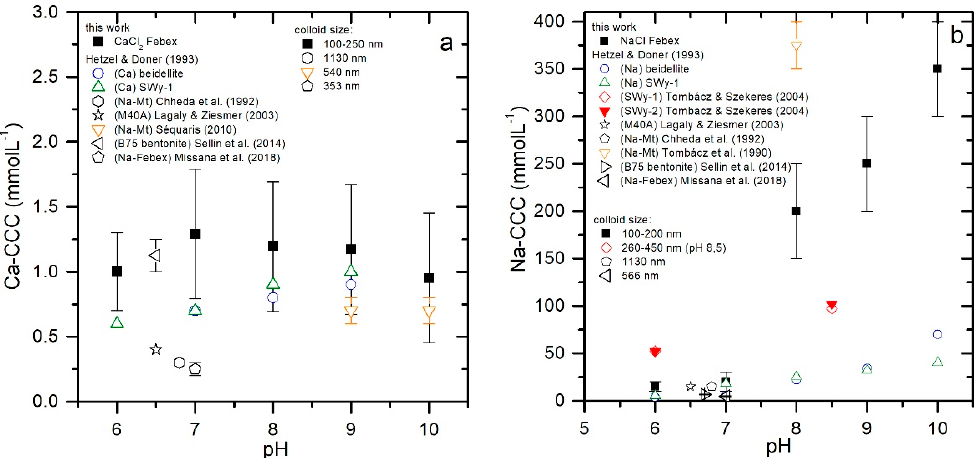
Figure 3. Critical coagulation concentration (CCC) plotted against pH for CaCl 2 ( a ) and NaCl ( b ). The Ca-CCC does not change within the analytical uncertainty for the investigated pH range. For comparison, the CCC data and colloid sizes from Hetzel and Doner [52] for montmorillonite (Swy-1) and beidellite; Na-montmorillonite from Séquaris [53]; Na-montmorillonite (Wyoming, M40A) from Lagaly and Ziesmer [55]; Na-montmorillonite (Fischer) from Chheda et al. [56]; Wyoming montmorillonite Swy- 1 and Swy-2 from Tombácz and Szekeres [59]; Na-montmorillonite from Tombácz et al. [60]; B75 bentonite from Sellin et al. [54]; and Na-FEBEX from Missana et al. [22] were inserted. The Na-CCC values for pH 6 and 7 are within the range found in the literature, whereas for pH 8 to 10, considerable variation is present. Possible explanations are given in the text.